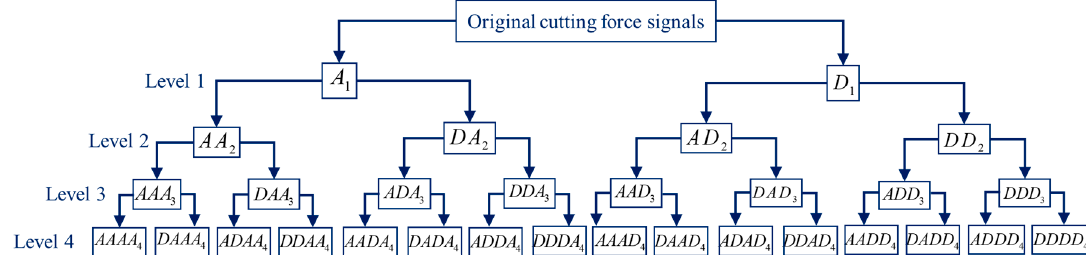
Figure 9. Structure diagram of WPT.